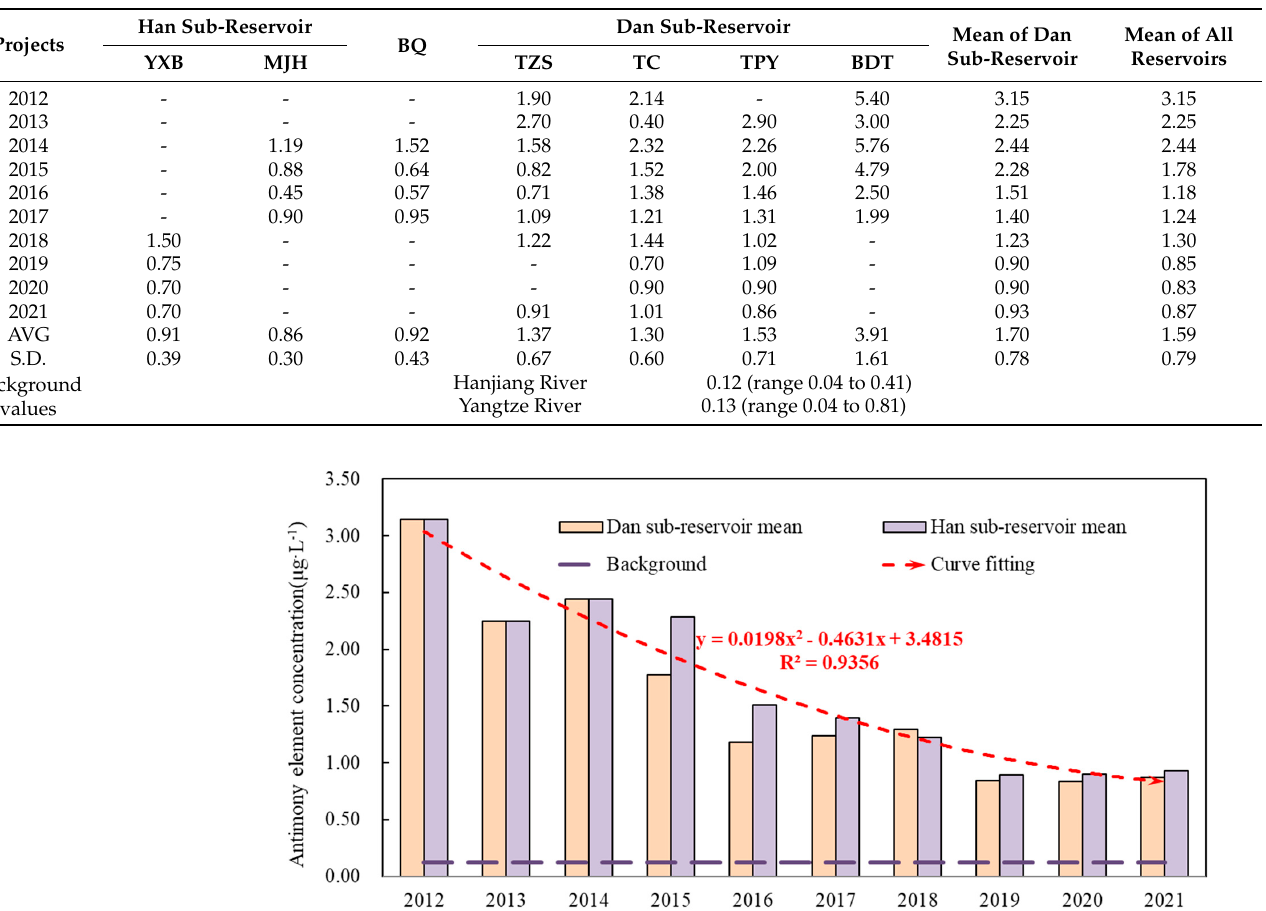
Figure 2. Trend of antimony concentrations in Danjiangkou Reservoir water. The red dotted line in the figure is the fitting curve of the mean antimony concentration in the Han sub-reservoir and Dan sub-reservoir as a function of time.